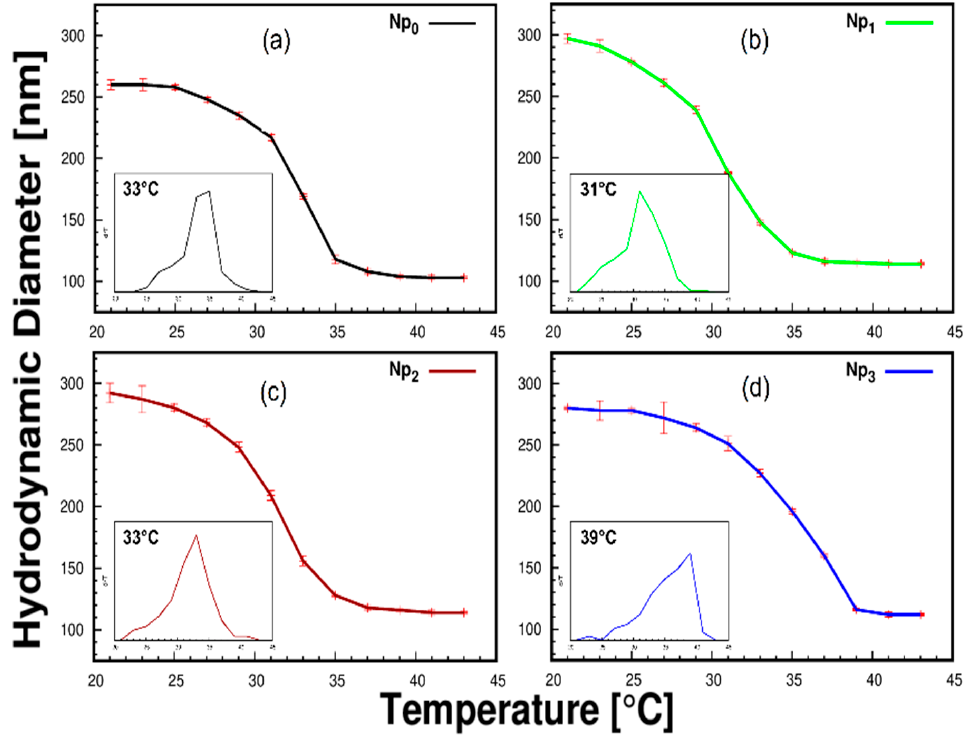
Figure 2. Effect of temperature and nanoparticle sizes of samples ( a ) Np 0 ; ( b ) Np 1 ; ( c ) Np 2 , and ( d ) Np 3 in aqueous media, examined by dynamic light scattering measurements. The temperature values refer to the phase transition. The inset graphics represent the LCST behavior between nanoparticle size and temperature.